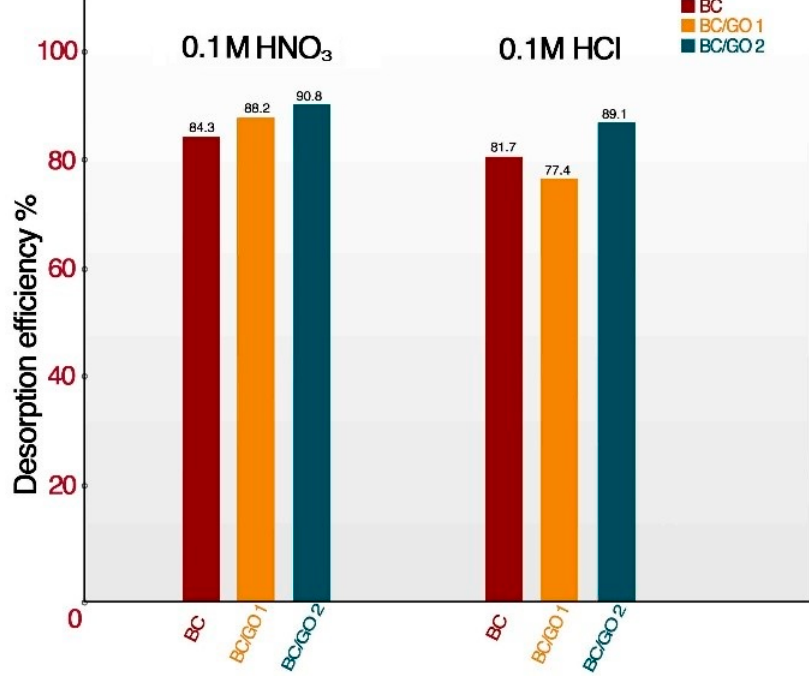
Figure 11. Desorption results with the use of HNO 3 and HCl for Pb 2+ .